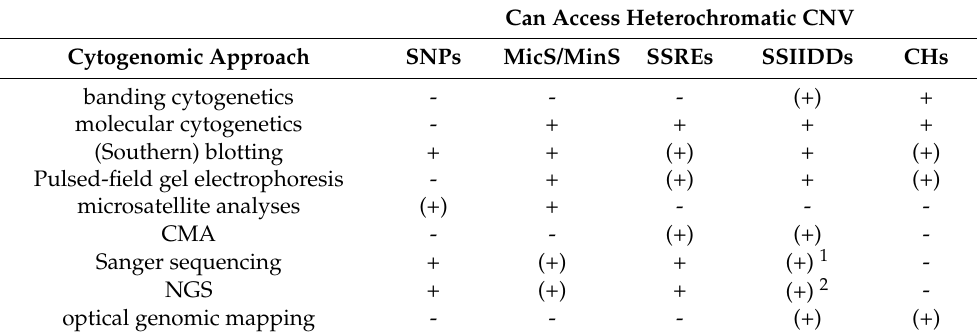
Table 1. Overview on cytogenomic approaches and their ability to access heterochromatic CNVs based on technology (Table according to information from